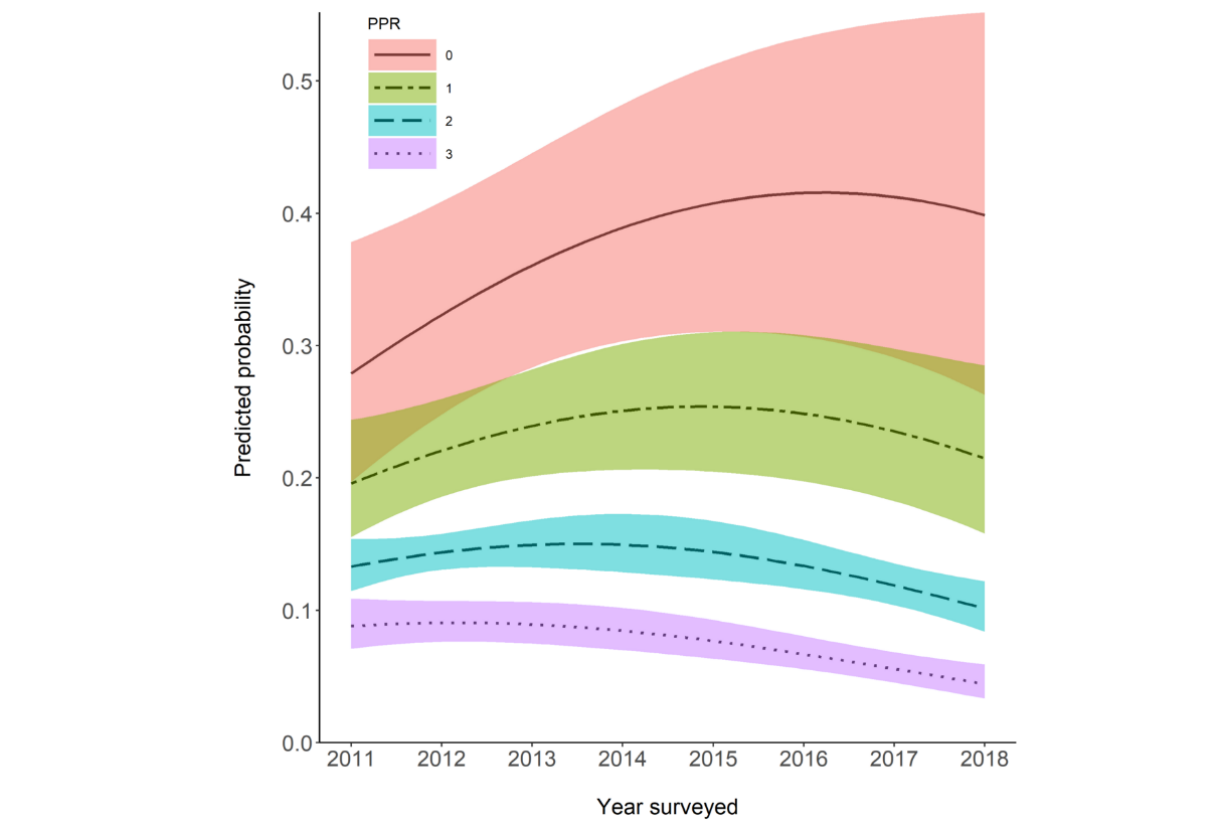
Figure 5. Predicted probability of withholding information behaviors at various patient-physician relationship values. PPR: patient-physician